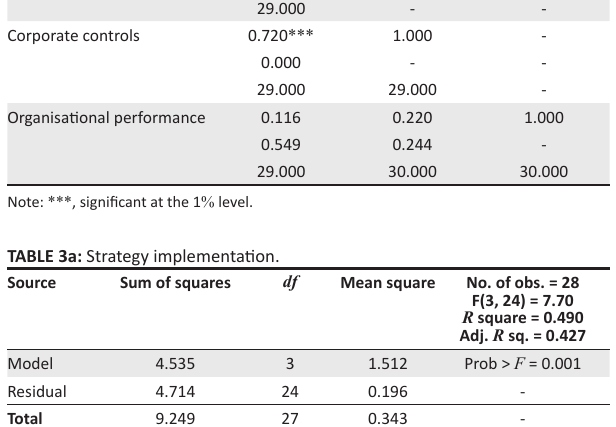
TABLE 2: Correlational matrix. Variable Strategy Strategy implementation